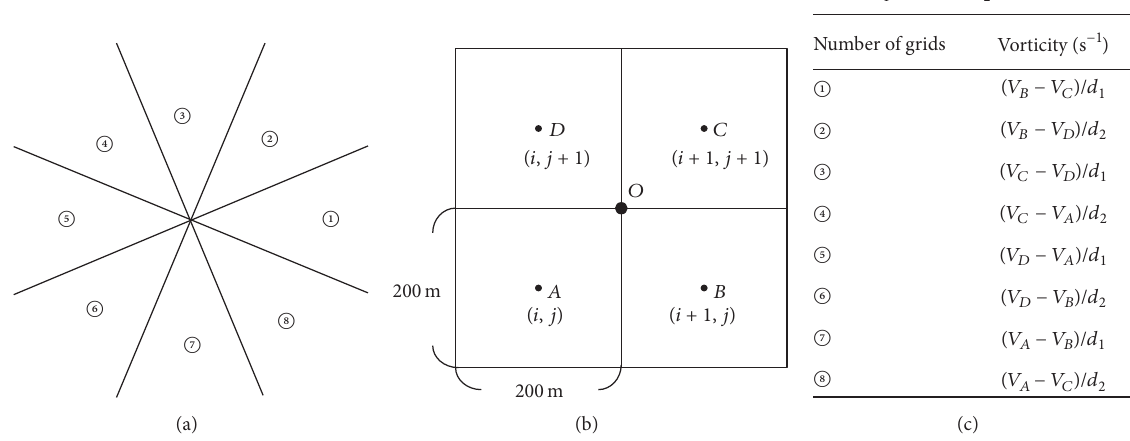
as hazardous when slight rainfall appeared on the